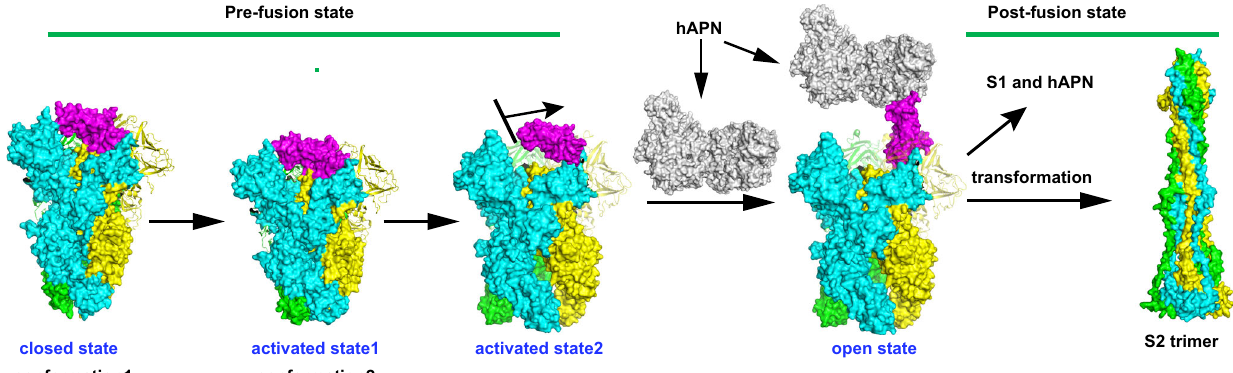
Fig. 4 Proposed pre- to post-fusion transition model of the HCoV-229E S trimer. The activated state 2 model and open state model were generated by superimposing the RBD-hAPN complex crystal structure (PDB ID 6ATK) onto the previously reported HCoV-229E structure (PDB ID 6U7H) with some modi fi cations. And the structural model of the S2 trimer in the post-fusion state was predicted using SWISS-MODE based on the homologous structure of the MHV S2 trimer (PDB ID 6B3O). The HCoV-229E S trimer is depicted with each protomer in cyan, yellow and green, respectively. The S1-RBD in protomer and hAPN are colored as magenta and